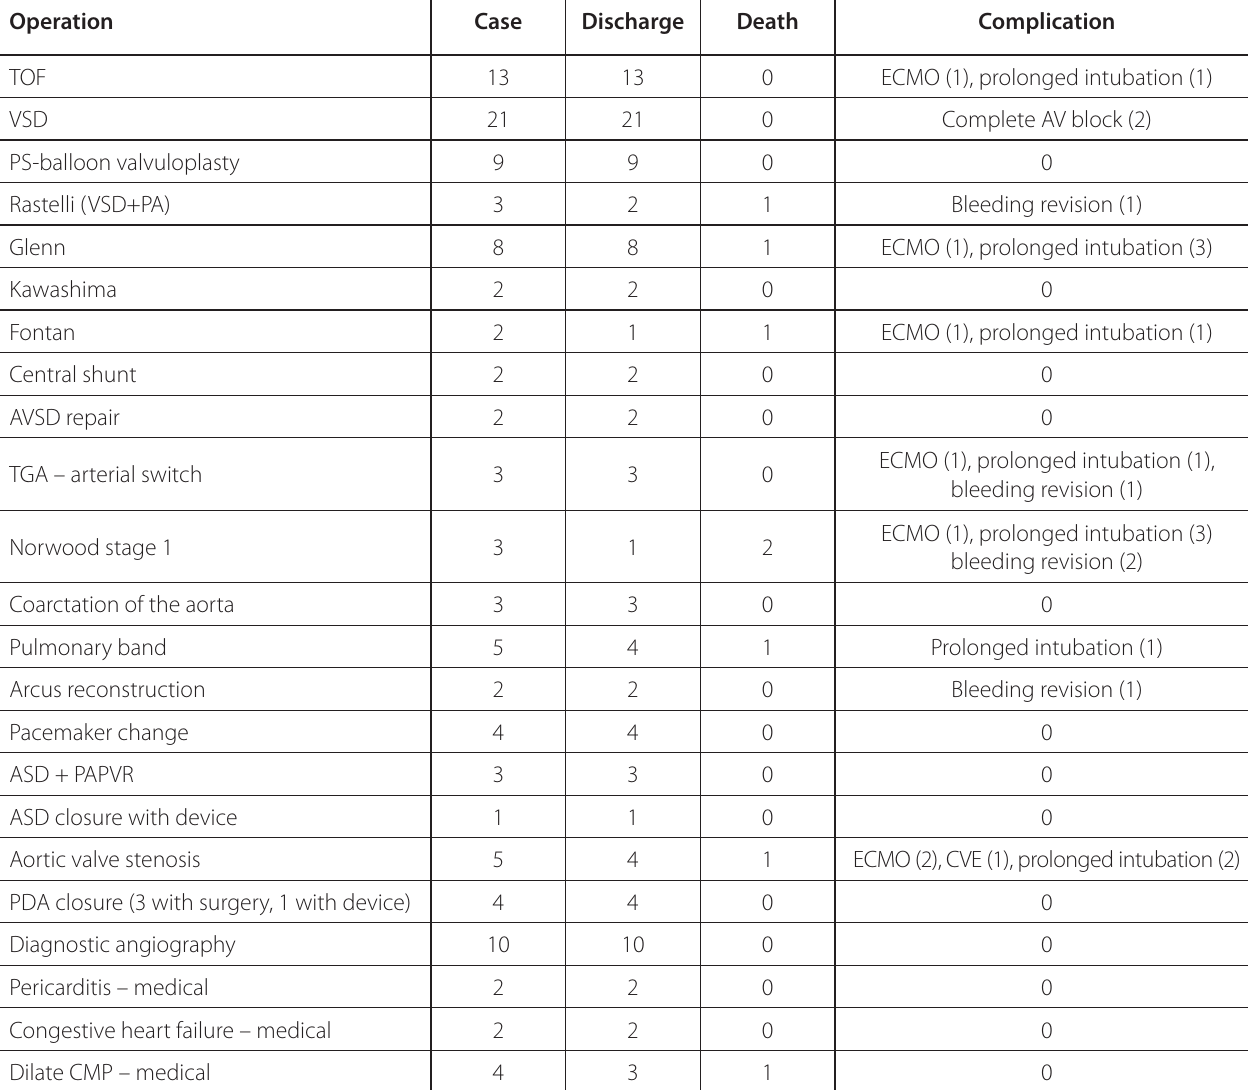
Table 2 . Operations and complications during the COVID-19